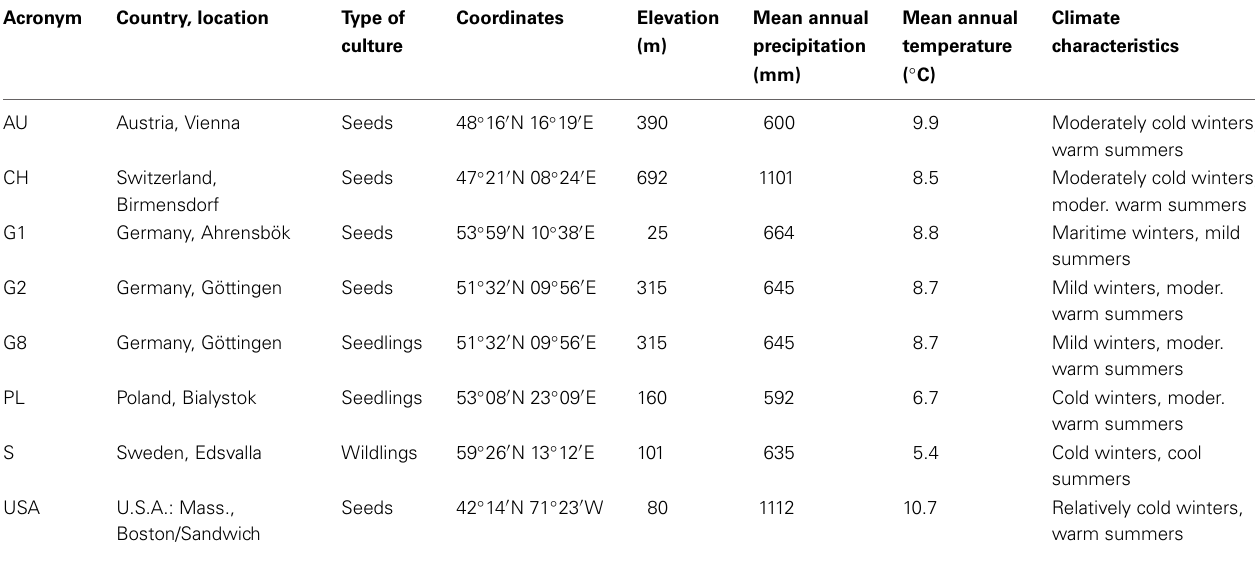
Table 2 | The eight aspen demes used in the study and their